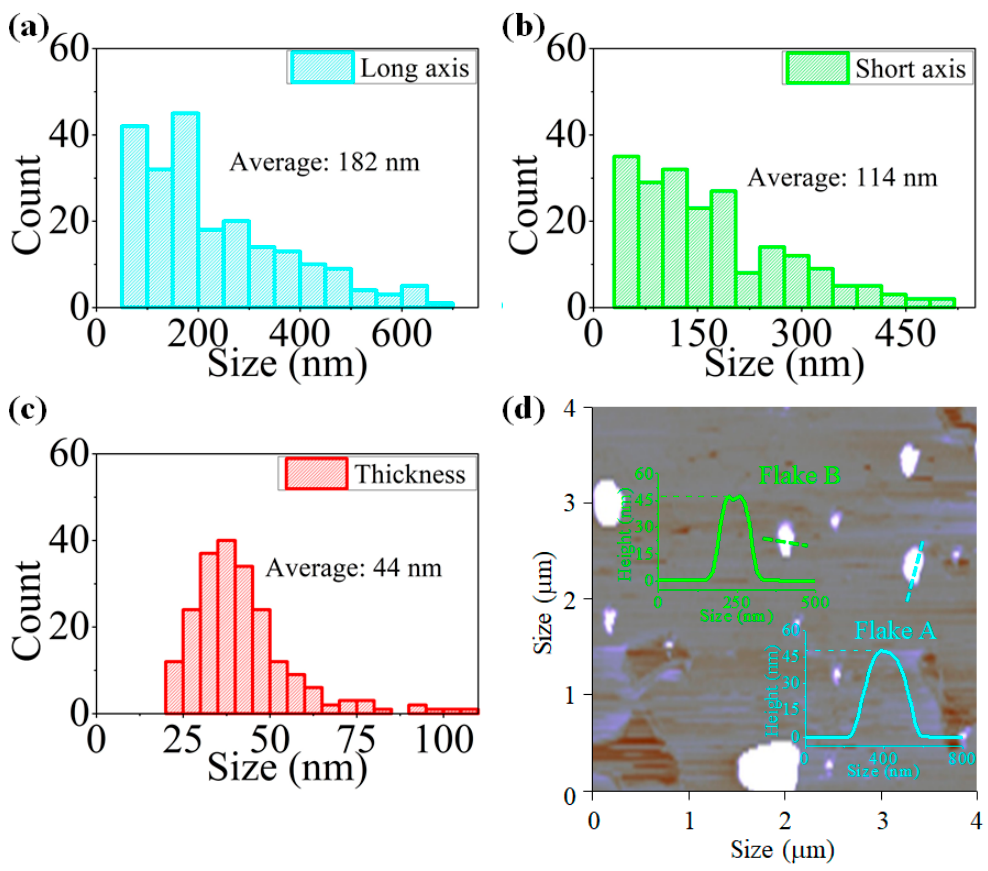
Figure 2. Statistical AFM measurement of 220 PdS 2 flakes, the lateral dimension of ( a ) long axis, ( b ) short axis and ( c ) thickness. ( d ) The image and height profile of selected Flake A and B along the marked line.